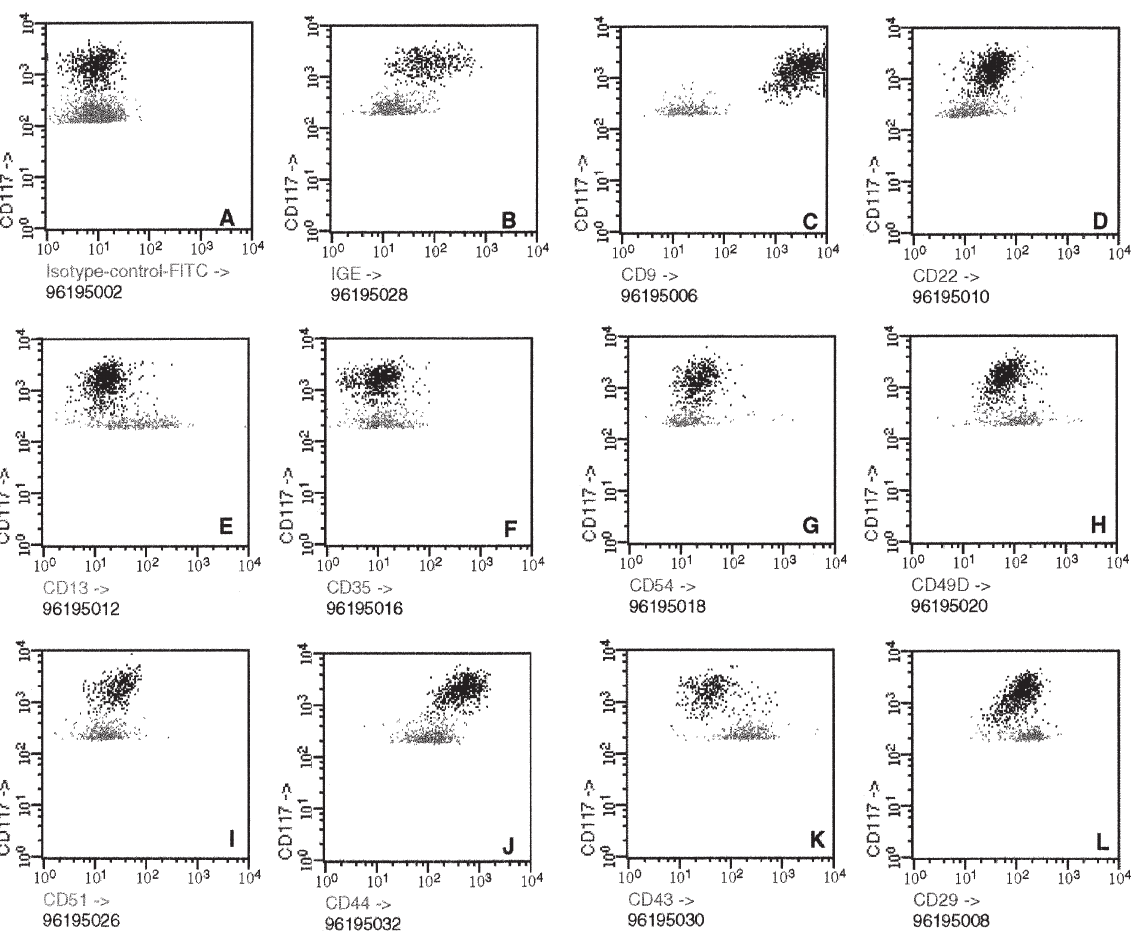
Fig. 1. Representative dot plots (A–L) of the immunophenotypic analysis of bone marrow mast cells (black dots) once selected on the basis of a high expression of CD117. MESF values ( × 10 3 ) were as follows: IgE, 40.0 (B); CD9, 134.4 (C); CD22, 9.9 (D); CD13, 4.5 (E); CD35, 2.7 (F); CD54, 6.3 (G); CD49d, 19.1 (H); CD51, 8.3 (I); CD44, 163.3 (J); CD43, 12.5 (K); CD29, 39.7